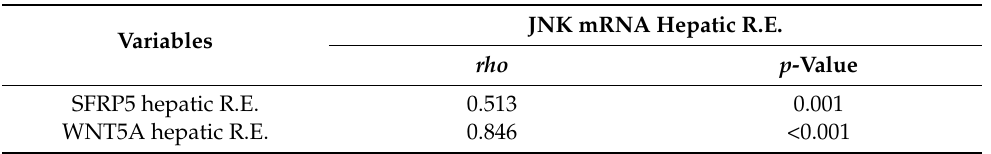
Table 3. Significant correlations between JNK relative hepatic expression with clinical and biochemi- cal parameters and with SFRP5 and JNK hepatic